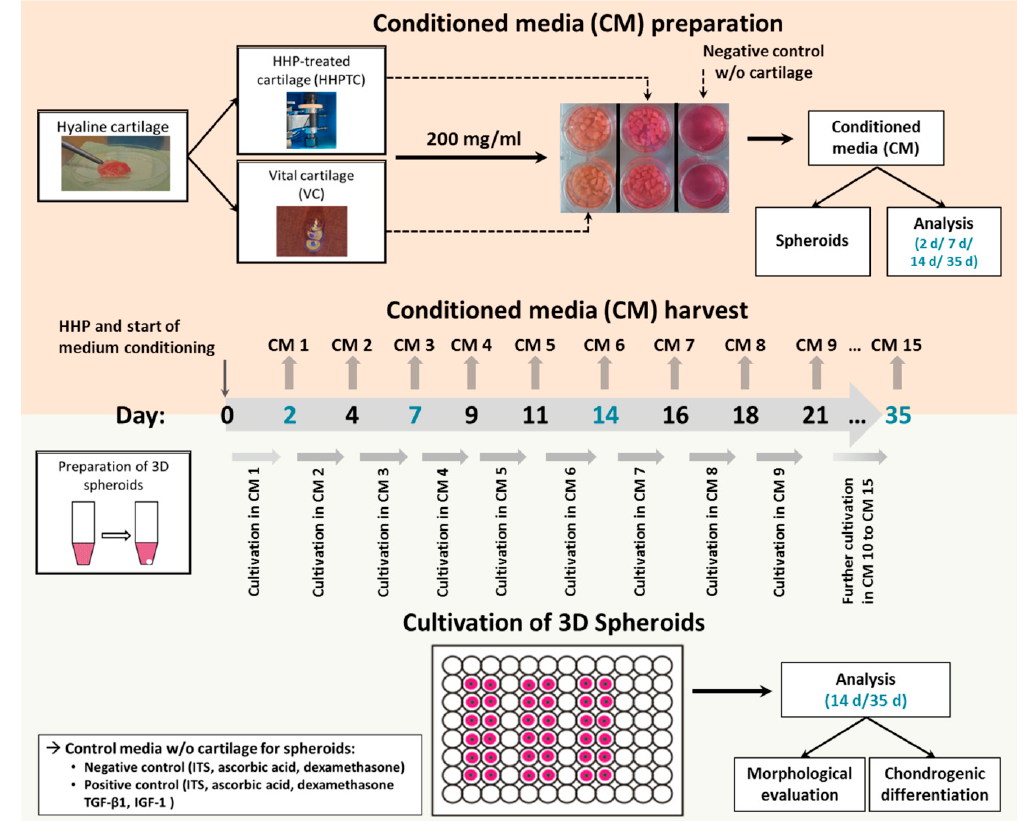
Figure 2. Flow diagram of experimental approach and methods. The upper panel (light orange) shows the preparation of conditioned medium of HHP ‐ treated and vital hyaline cartilage tissue. The tissue slices were cultivated for a total period of 35 days. Medium was changed and harvested every two to three days for subsequent use for 3D spheroid cultures. In addition, the release of soluble chondrogenic mediators was analyzed on day 2 (conditioned medium (CM) 1), day 7 (CM 3), day 14 (CM 6) and day 35 (CM 15). The lower panel (light green) depicts the preparation and cultivation of chondrocytic spheroid cultures. After a two ‐ day incubation in basal medium (negative control medium), spheroids were supplied with the respective CM of vital and HHP ‐ treated cartilage. Spheroids, cultivated with basal medium containing ITS™, ascorbic acid and dexamethasone (negative control) or basal medium plus chondrogenic growth factors TGF ‐β 1 and IGF ‐ 1 (positive control) served as controls. After 14 d and 35 d of incubation, spheroids were analyzed regarding morphological changes and chondrogenic differentiation.